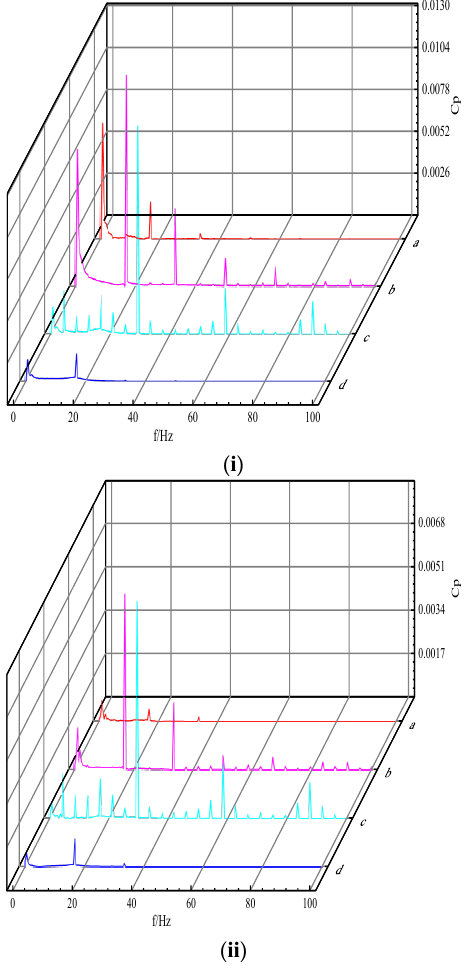
Figure 12. Frequency domain diagram of the pressure pulsation under turbine condition. ( ⅰ ) 0.6Q. ( ⅱ ) 1.0Q. ( ii )